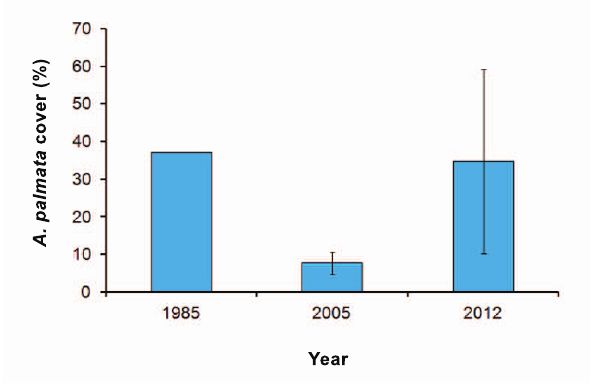
Figure 4. Mean percent Acropora palmata cover ( ± SD) in Limones reef site in 1985, 2005 and 2012. Data for 2005 were taken by the Puerto Morelos Reef National Park staff in four 30-m permanent transects in November 2005 after the impact of Hurricanes Emily (July) and Wilma (October). Only the mean value is reported for